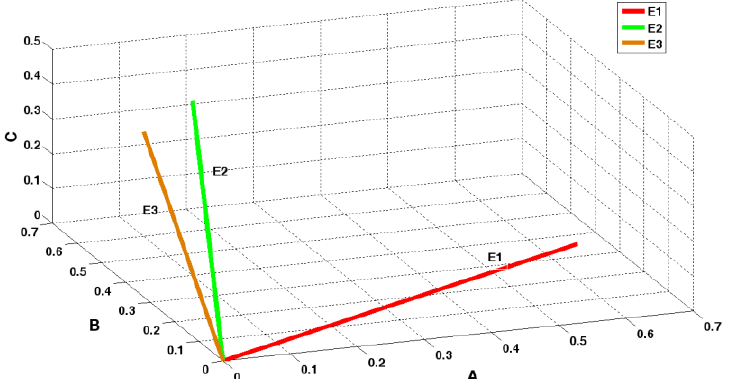
Figure 1. Vector space graph of belief assignment function in Example